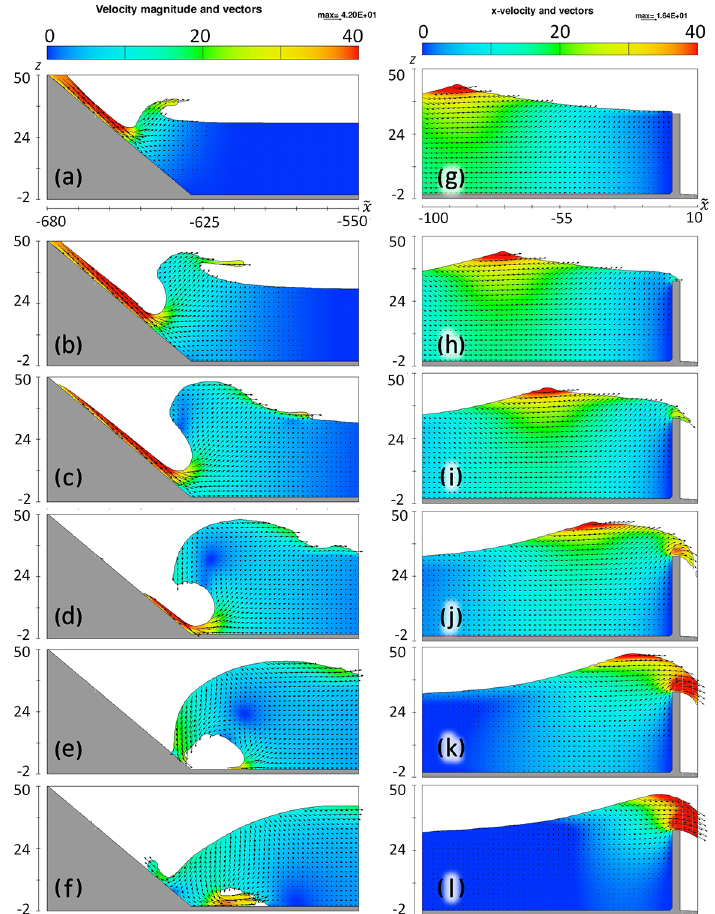
Figure 3. Exemplary results of the reference case. Left column (a)–(f) : impact of the avalanche starting at 1s after the start of the simulation, coloured by the velocity magnitude with a fixed upper value of 40ms − 1 . Right column (g)–(l) : overtopping starting at 30.4s ( (cid:49)t between each picture is 1s), coloured by the x velocity with a fixed upper value of 10ms − 1 (vectors show the 2-D velocity–length dimension of the axis in